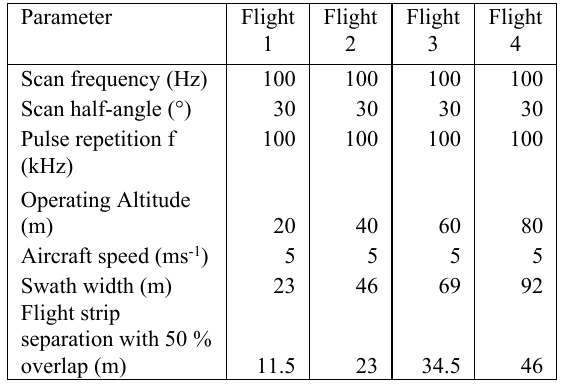
Table 1. Parameters of all four